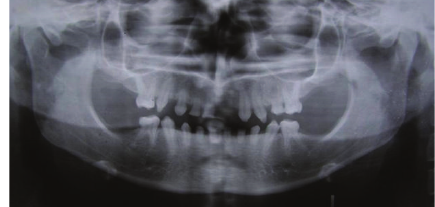
Figure 1: Preoperative radiograph showing overretained deciduous teeth and a few permanent teeth.